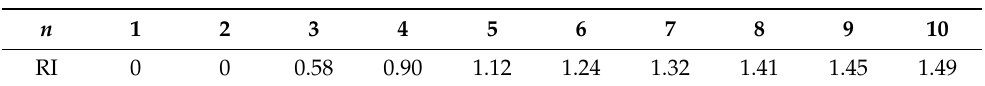
Table 5. Random consistency index (RI)